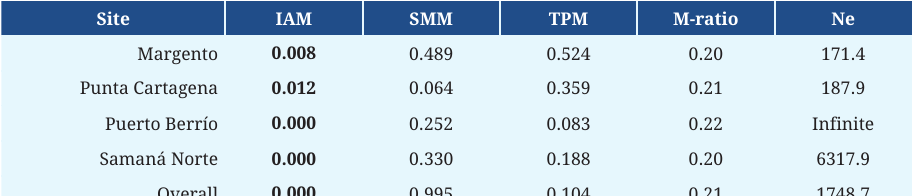
TABLE 3 | Bottleneck test and effective population size (Ne) estimation in four sampling sites of the Magdalena-Cauca basin. P-values from one tailed Wilcoxon signed-rank test under infinite alleles model (IAM), stepwise mutation model (SMM) and two-phase mutation model (TPM). M-ratio: modified index of Garza-Williamson. Values in bold denote statistical significance after correction for multiple comparisons.